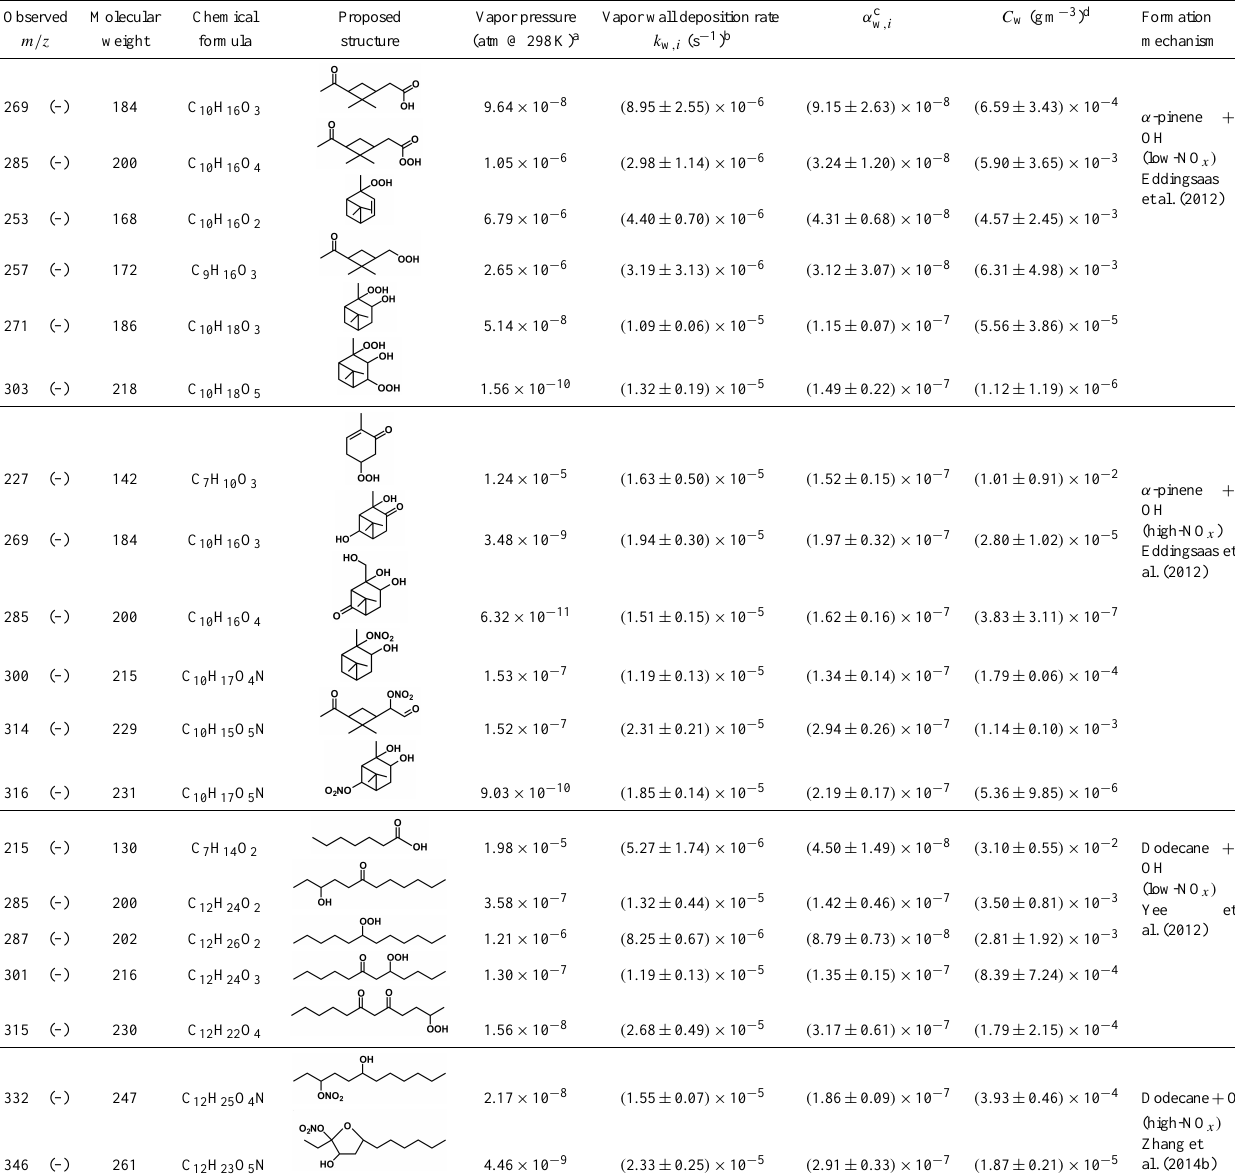
Table 2. Best-fit values of vapor–wall accommodation coefficient ( α w ,i ) and calculated equivalent absorbing organic mass ( C w ) on the chamber wall for vapors with structure proposed based on the CIMS